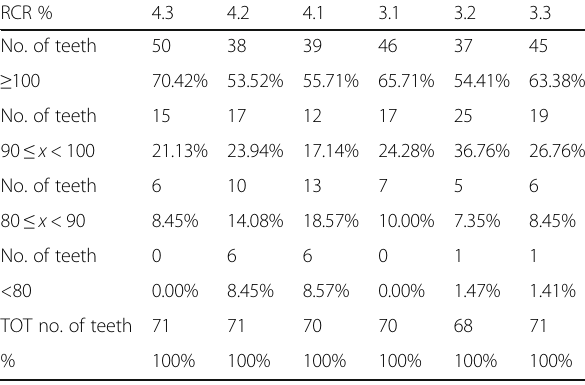
Table 4 Number and percentage of the lower teeth presenting between 80 and 90 (moderate RR), and rRCR = 80 (severe